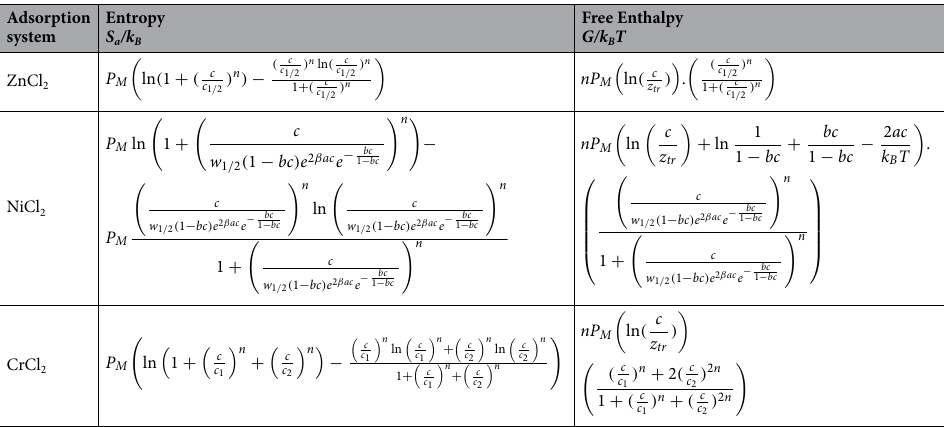
Table 7. Analytical expressions of the entropy ( S a /k B ) and the free enthalpy ( G/k B T ) of the two mono-layer adsorptions of zinc and nickel and the L.B.L double-layer adsorption of chromium.